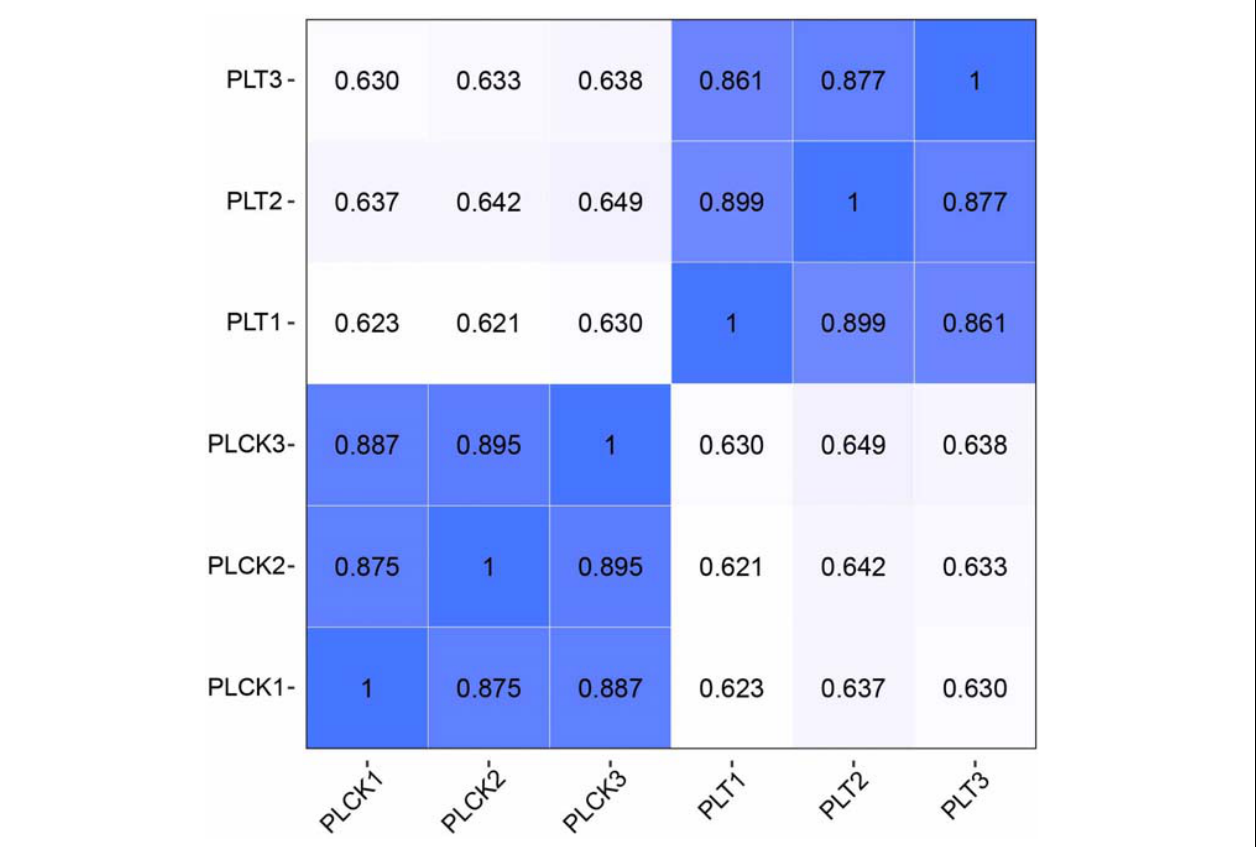
FIGURE 3 | Heatmap of the Pearson’s correlation coefficient for different samples. Greater values and darker-blue squares represent higher similarity between two sequencing libraries. PLT1–PLT3 indicate RNA-seq libraries of P. lilacinum infecting M. incognita eggs in three biological replicates, respectively; PLCK1–PLCK3 indicate RNA-seq libraries of P. lilacinum (controls) in three biological replicates,